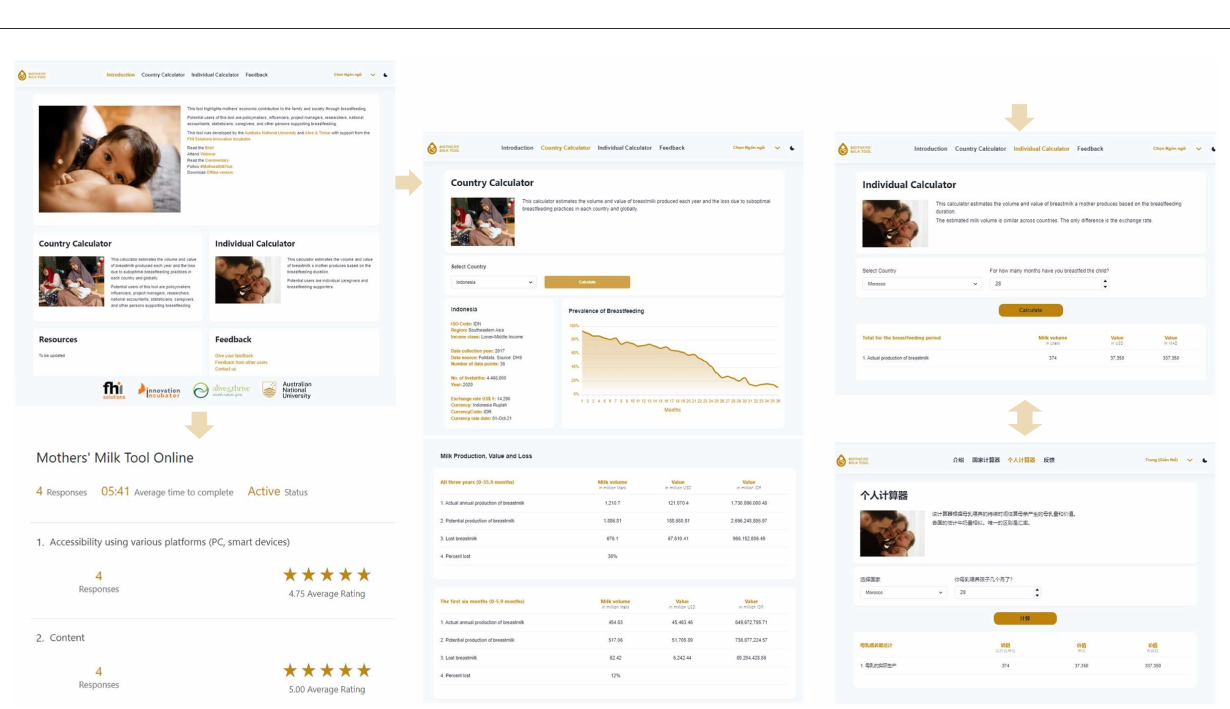
FIGURE2 Layout and key features of the Mothers’ Milk Tool online. Authors created this figure using snapshots of the Mothers’ Milk Tool online (https:// mothersmilktool.org). The human identifiable images are licensed for personal, business or commercial